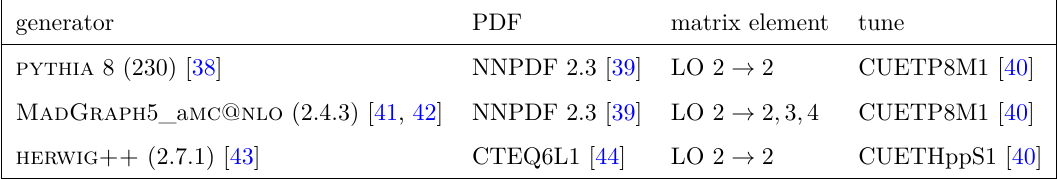
Table 2 . Description of the simulations used in the